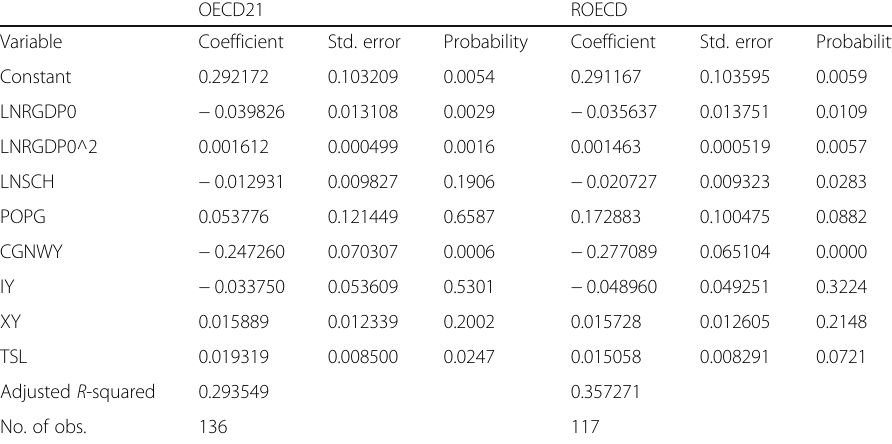
Table 11 Barro regression including TSL